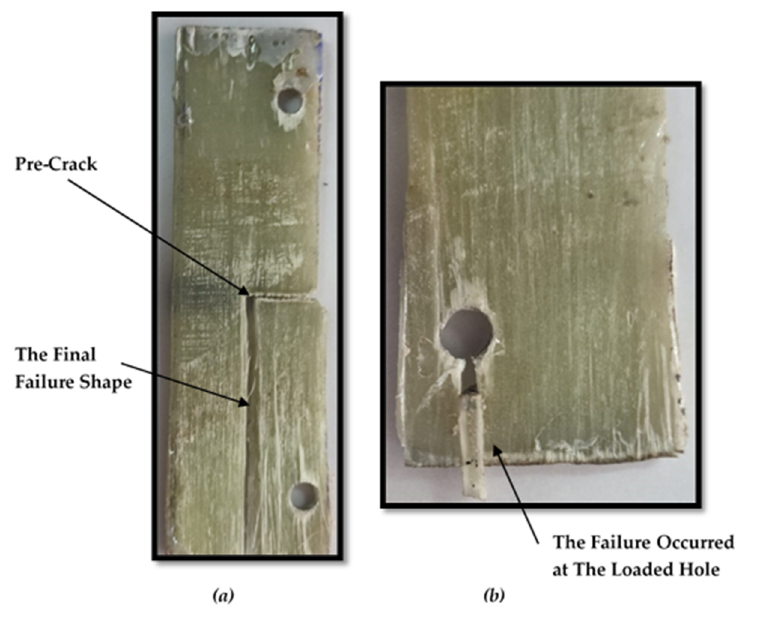
Figure 8. Photographs showing the progressive damage for ( a ) TTC ASTM E1922 specimen and ( b ) MC ASTM E1922 specimen.